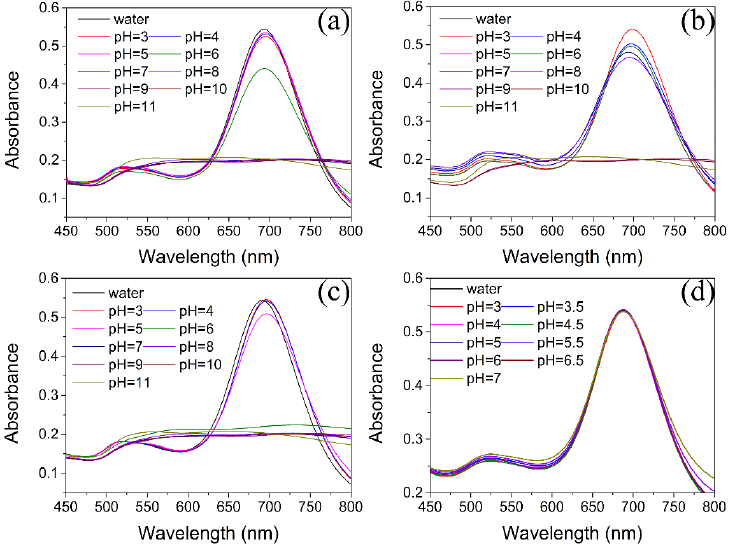
Figure 5. Effects of pH and buffer media on UV-vis spectra of AuNRs: ( a ) 10 mM PBS; ( b ) 10 mM Tris-HCl; ( c ) BR buffer; ( d ) 10 mM NaAc-HAc.